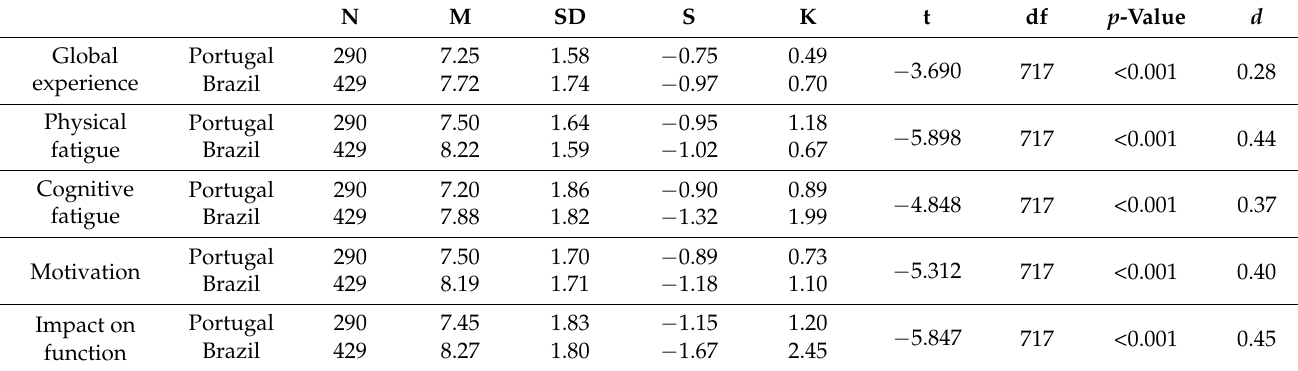
Table 1. Descriptive statistics of each variable according to samples (Portugal and